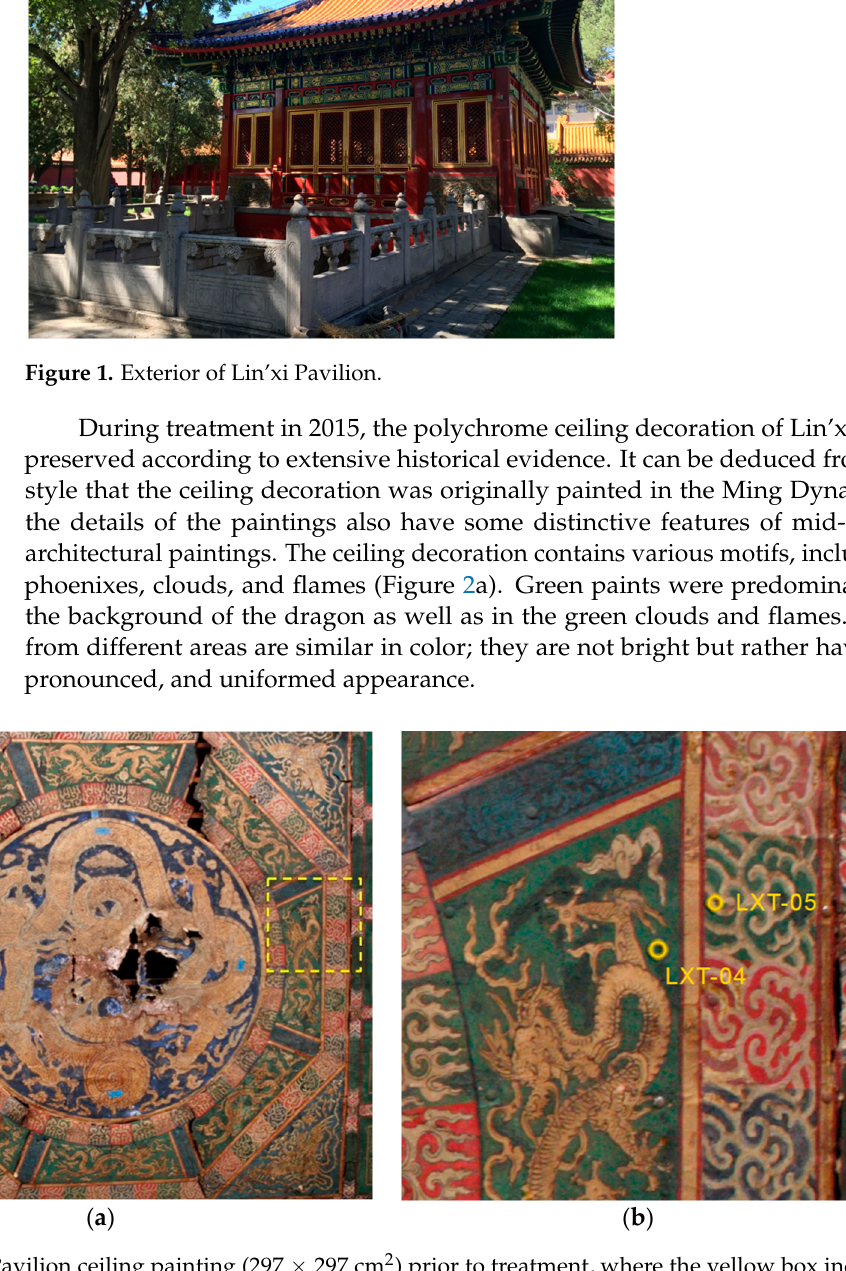
Figure 2. ( a ) The Lin’xi Pavilion ceiling painting (297 × 297 cm 2 ) prior to treatment, where the yellow box indicates the region ( b ) where samples were located, indicated by yellow circles.